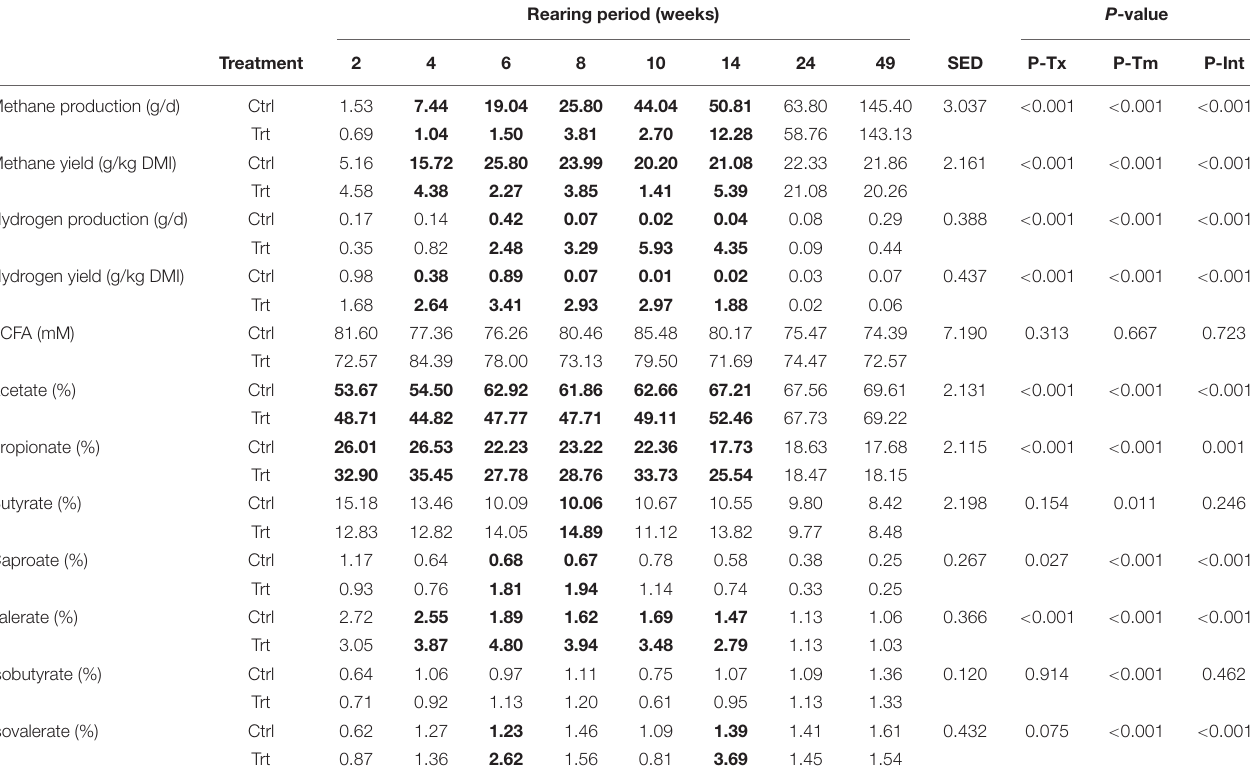
TABLE 4 | Effect of methane inhibitors 1 on rumen function 2